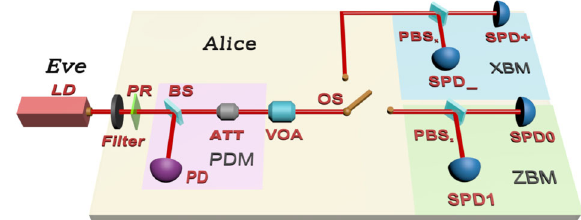
Fig. 1 A schematic diagram of a SI-QRNG. Eve controls the laser diode (LD) and sends pulses with states that are changed to mixed states through a fi lter and a phase randomizer (PR). Through a photon distribution monitor (PDM) which consists of a beam splitter (BS), an attenuator (ATT), a photodiode (PD) and a variable optical attenuator (VOA), the pulses are sent to an optical switch (OS) to choose the measurement basis-the X basis measurement (XBM) or Z basis measurement (ZBM)-both of which consist of a polarization beam splitter (PBS) and two single photon detectors (SPD). The PDM block is used for the distribution monitor and does not exist in general SI-QRNGs in the ref. 31